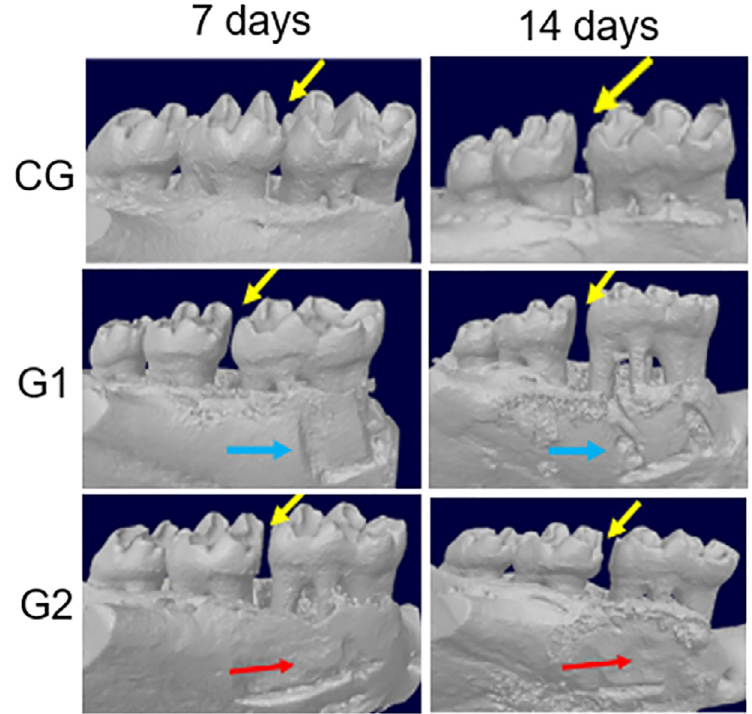
Figure 3- Transverse plane images performed on high-resolution microcomputer